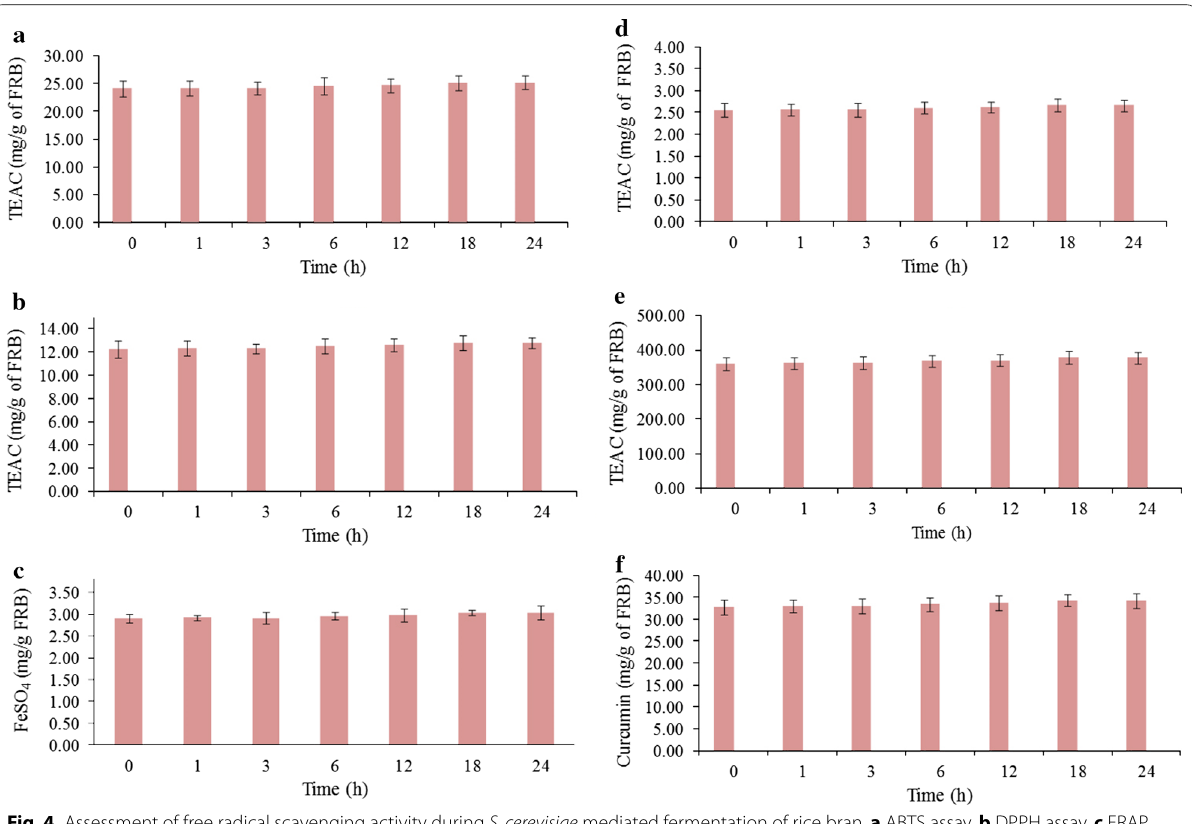
Fig. 4 Assessment of free radical scavenging activity during S. cerevisiae mediated fermentation of rice bran. a ABTS assay, b DPPH assay, c FRAP assay, d inhibition of lipid peroxidation, e superoxide and f nitric oxide radical scavenging assays for fermented rice bran. a ABTS assay, b DPPH assay, d inhibition of lipid peroxidation, e superoxide radical scavenging assays results were represented as trolox equivalent of antioxidant capacity (TEAC). FRAP assay and nitric oxide scavenging assay results were denoted as FeSO 4 equivalent/g of FRB and curcumin equivalent/g of FRB, respec-